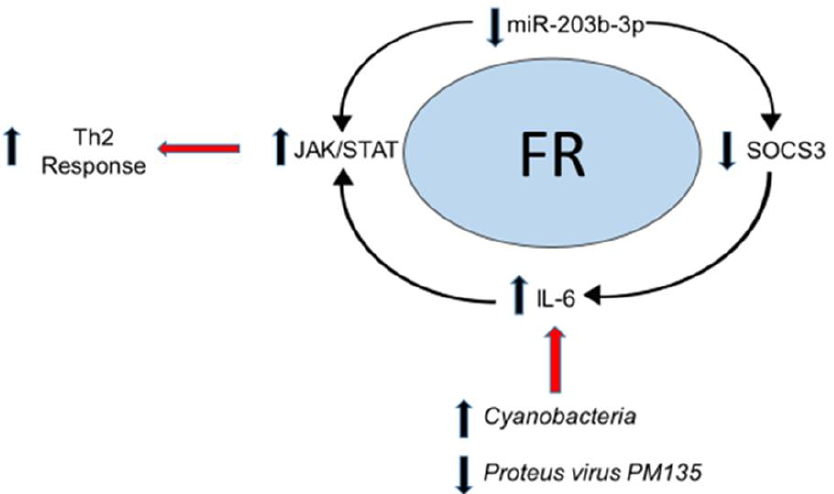
Figure 4. Conceptual framework model of host–microbial interactions in food reactions: The results of this study support a conceptual framework for FR pathophysiology involving host–microbiome interactions. Elevated levels of pathogenic Cyanobacteria may directly induce inflammatory cytokines such as interleukin-6 (IL-6). IL-6 is a known activator of the JAK-STAT pathway, resulting in a Th2 response. Host microRNA responses (such as a decrease in miR-203b-3p) have been shown to indirectly stimulate JAK2/STAT3 signaling by increasing the levels of IL-6 through the regulation of the suppressor of cytokine signaling (SOCS3), which normally suppresses the downstream effects of IL-6. Red arrows depict secondary processes associated with the conceptual food reaction pathway.